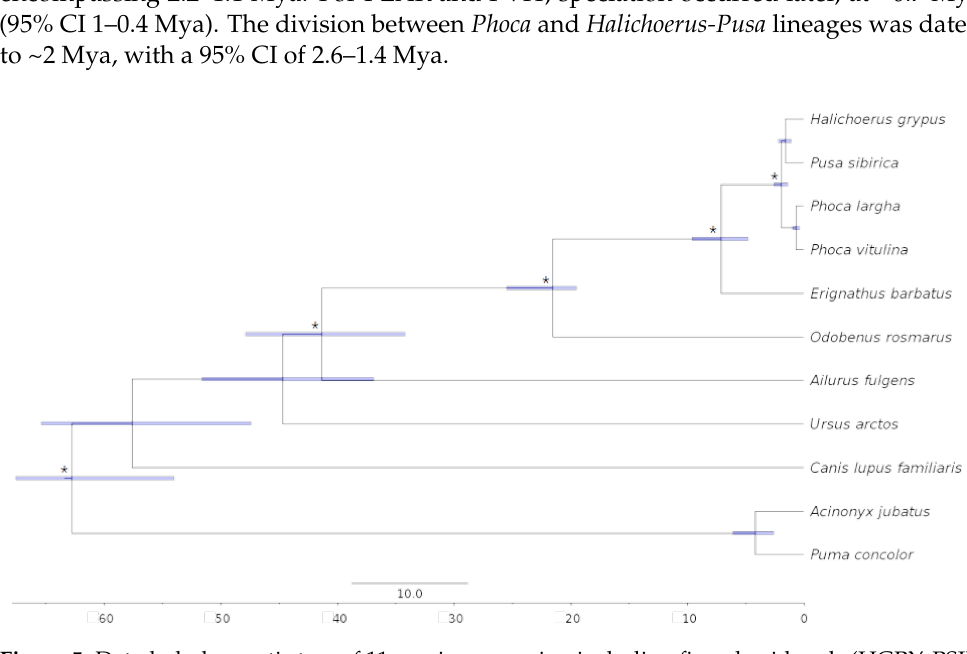
Figure 5. Dated phylogenetic tree of 11 carnivore species, including five phocid seals (HGRY, PSIB, PLAR, PVIT, and EBAR). Blue bars show the 95% confidence intervals. Asterisks (*) label nodes with fossil-based calibration priors (Supplementary Table S8). All nodes were supported at 100% based on 1000 bootstrap replicates.